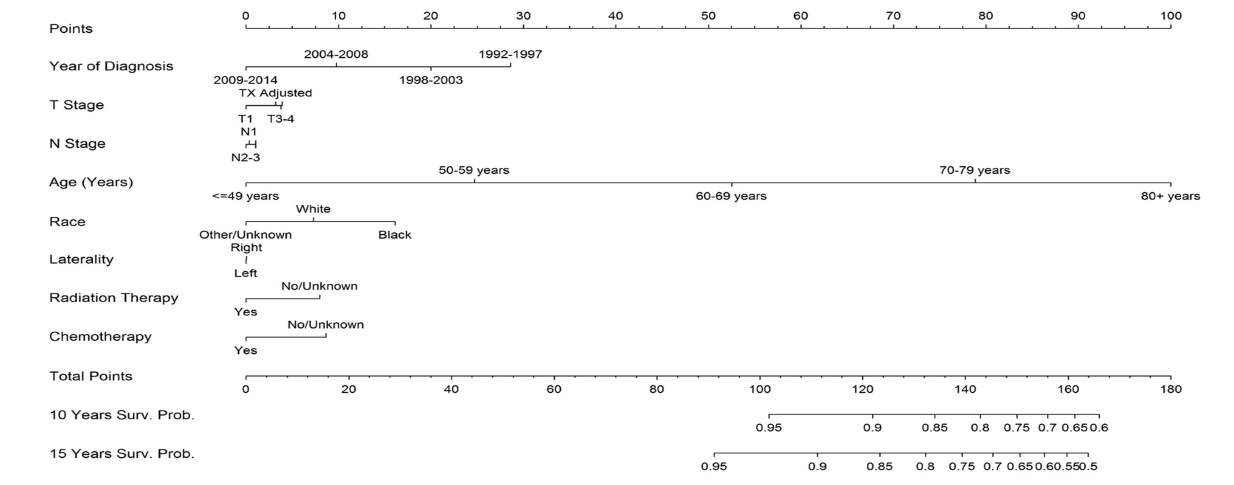
Supplementary Figure 1 | (A,B) The Y -axis represents SMR for death from heart disease and the X -axis depicts the time since diagnosis in years. Each color represents patients either treated with no radiation (blue) or treated with radiotherapy (orange). Panel (A) are patients diagnosed before 2000 and panel (B) are patients treated post 2000. Patients were selected only based on their